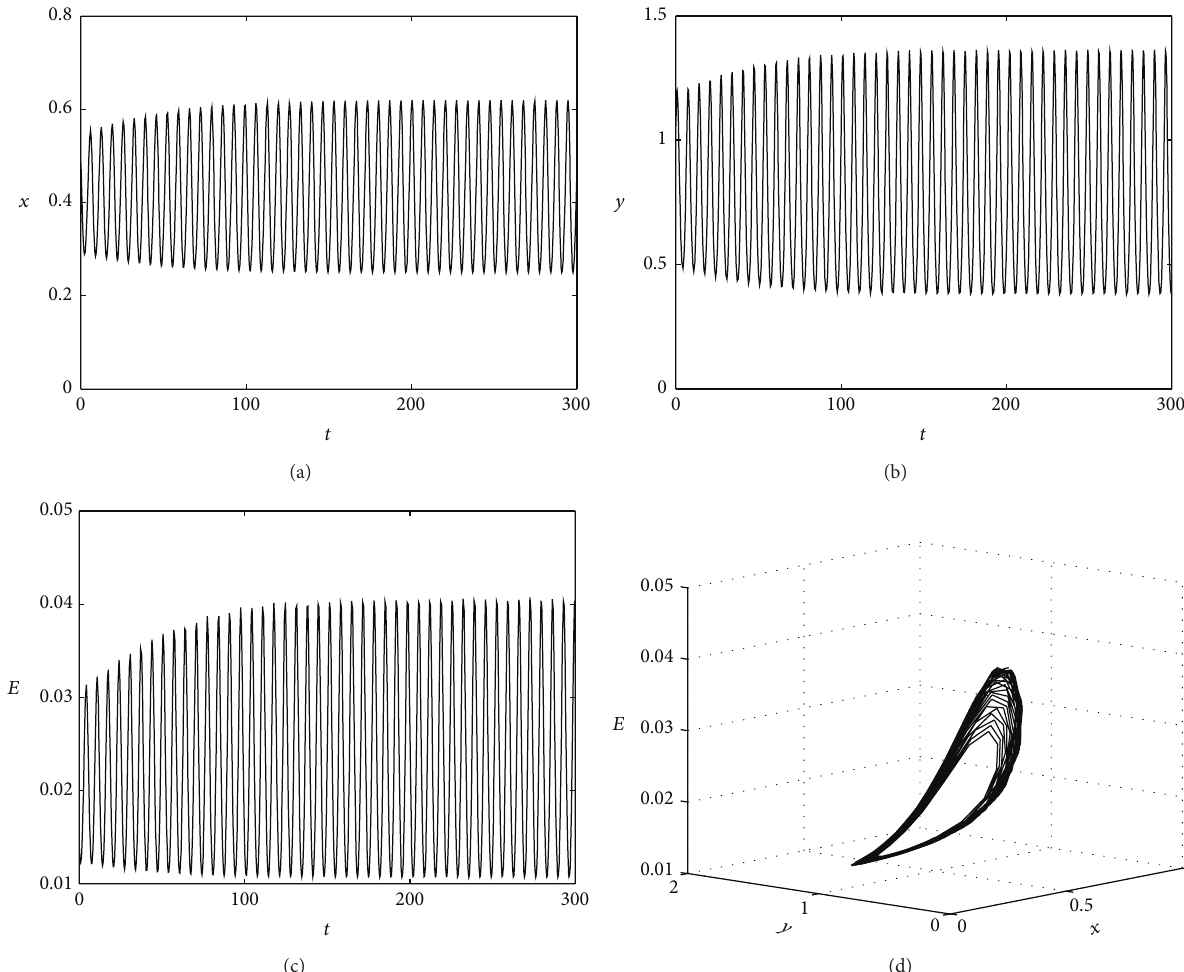
Figure 4: When at 𝜏 1 = 𝜏 󸀠 10 = 0.6546 and 𝜏 ∗ 2 = 0.15 , bifurcating periodic solutions of model (1) from 𝑃 0 occur.